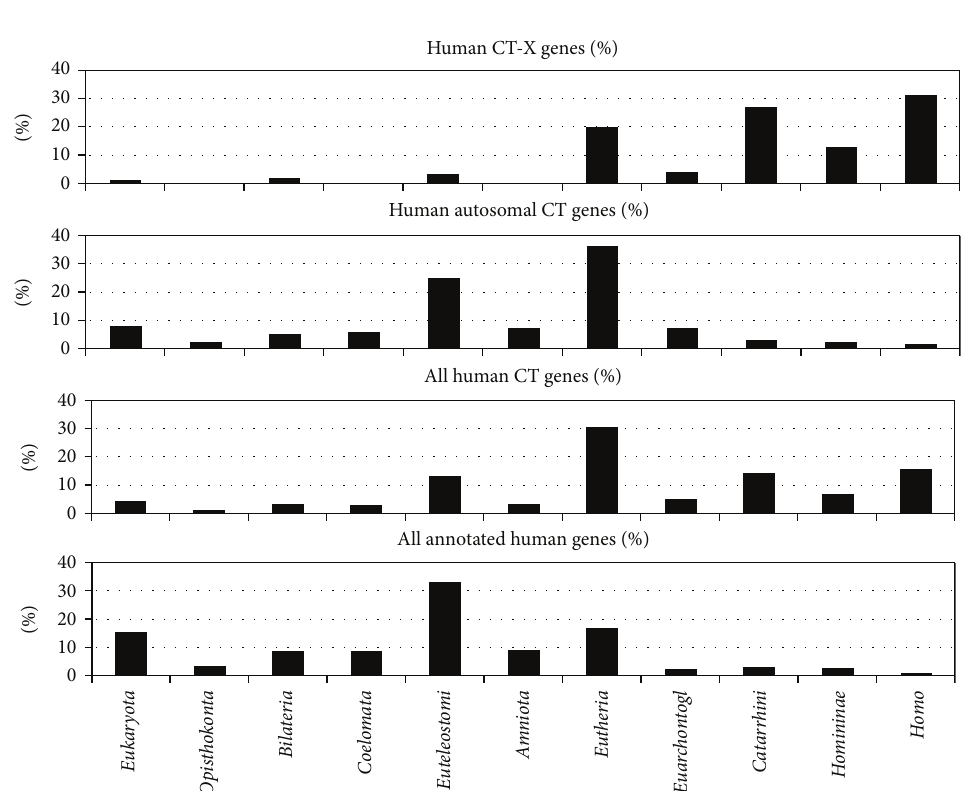
Figure 1: The proportions of CT-X genes, autosomal CT genes, all human CT genes, and all annotated human genes with orthologues originated in different taxa of H. sapiens